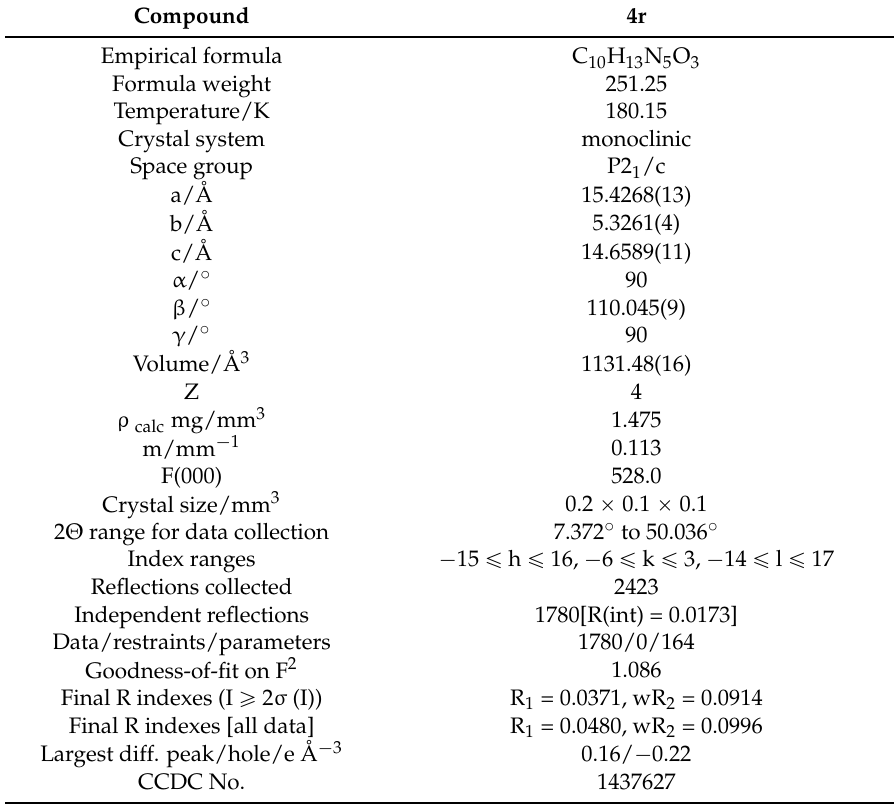
Table 1. Crystal data and structure refinement for 4r